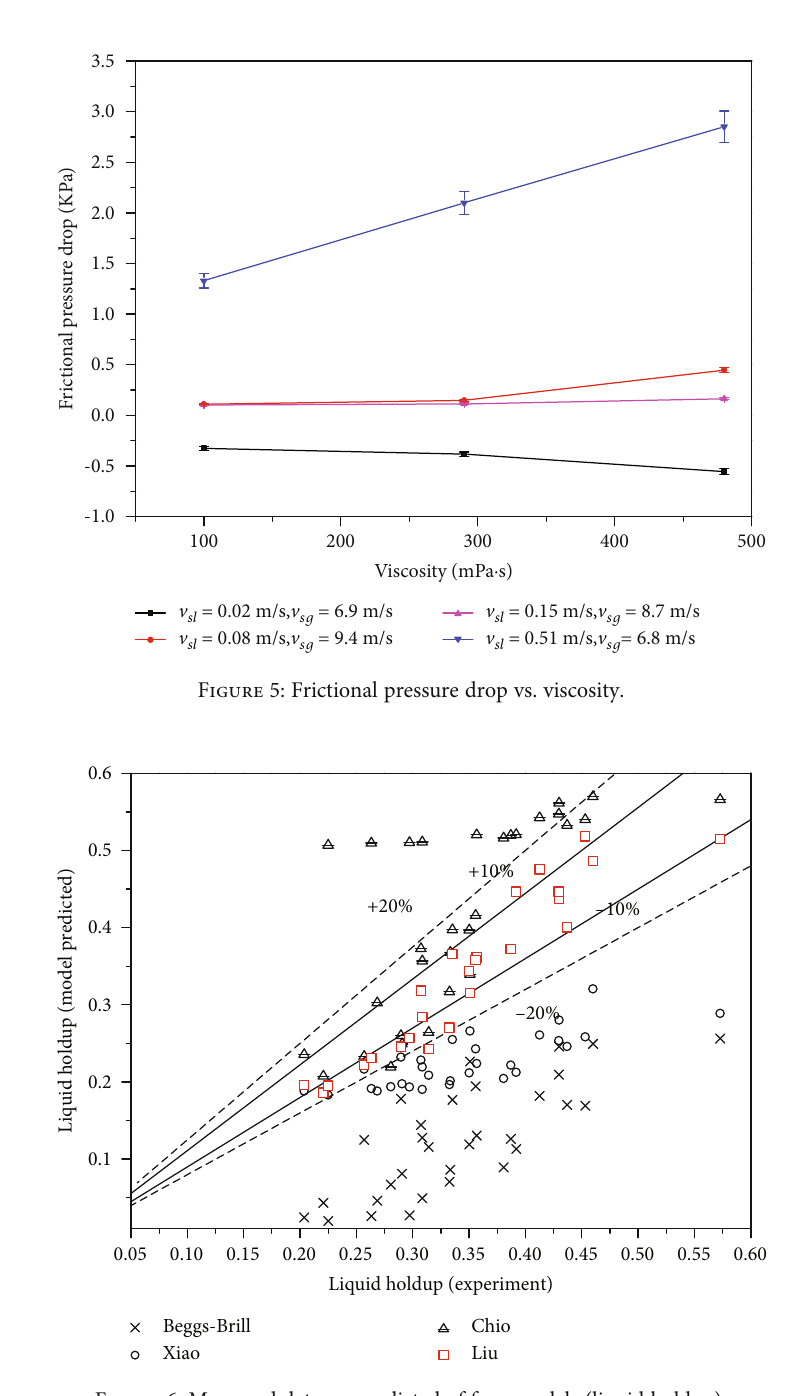
Figure 6: Measured data vs. predicted of four models (liquid holdup). Table 3: Errors of liquid holdup for four di ff erent